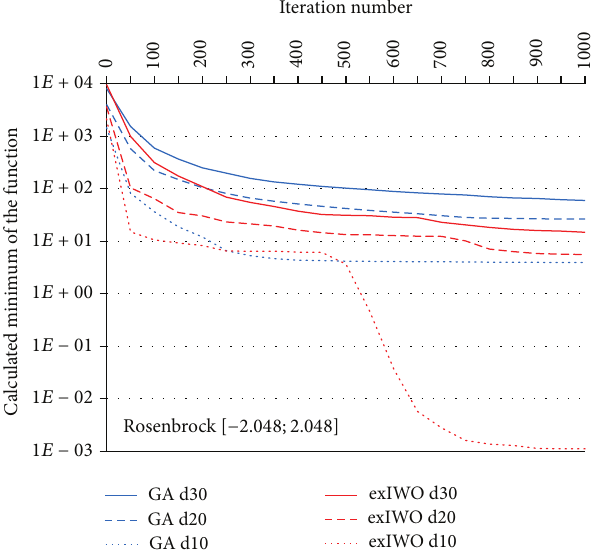
Figure 7: GA and exIWO convergence plot for the Griewank function.